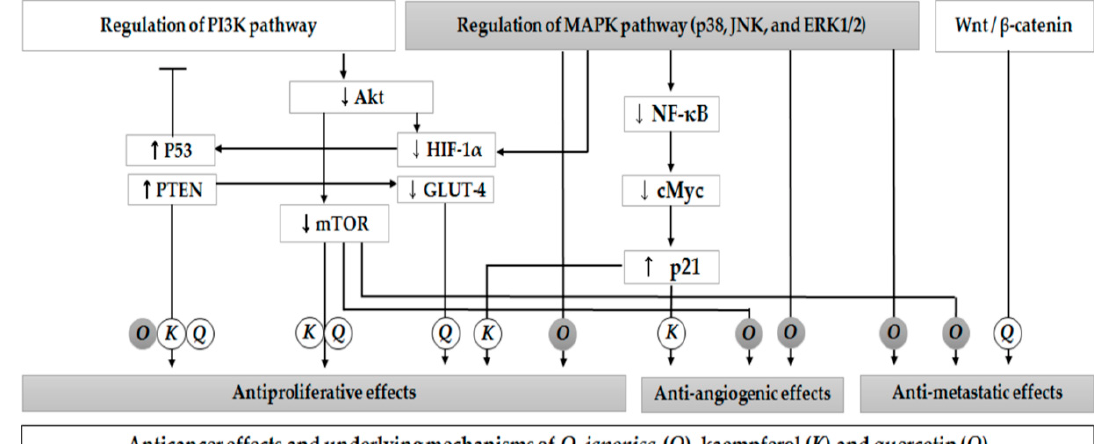
Figure 4. Anticancer effects and underlying molecular mechanisms of Orostachys japonica (O) and its two compounds (kaempferol (K) and quercetin (Q)). O. japonica increases the expression of tumor suppression gene p53 and regulates MAPK pathways, which involves the PI3K pathway and cancer glycolysis. These pathways may therefore control the expression of various markers contributing to the anticancer effects of O. japonica . Kaempferol and quercetin are shown to exhibit antiproliferative effects via PI3K signaling cascades. Quercetin inhibited HIF-1 α and GLUT-4 expression and regulated Wnt/ β -catenin. Kaempferol inhibited NF- κ B and c-Myc expression and upregulated p21 activity, thus suppressing tumor growth and angiogenesis. PTEN: phosphatase and tensin homolog; HIF: hypoxia-inducible factors; GLUT: glucose transporter; NF- κ B: nuclear factor kappa-light-chain-enhancer of activated B cells; c-Myc: cellular Myc.